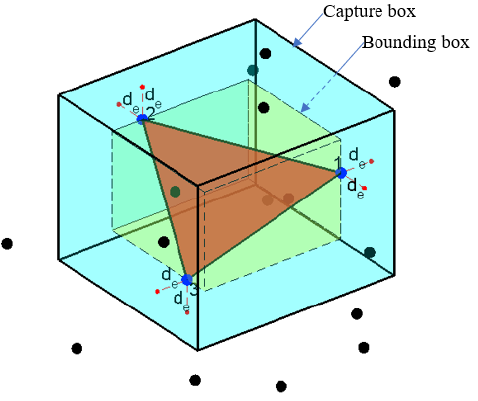
Figure 2. Schematic diagram of box test (Blue dot: master particle; Black dot: slave particle).